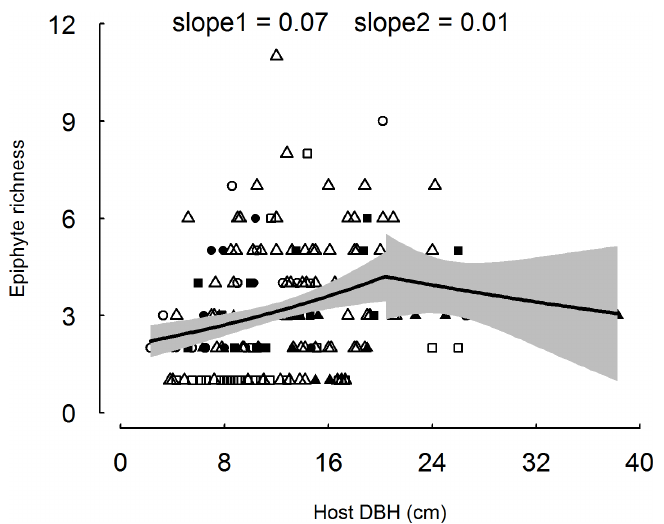
Fig 4. Relationship between the vascular epiphyte species richness and host tree diameter (DBH) across all six study species ( Engelhardtia roxburghiana , Ternstroemia gymnanthera , Syzygium buxifolium , Illicium ternstroemioides , Distylium racemosum and Cyclobalanopsis disciformis ), using a regression of breakpoints based on generalized linear model. Different symbols showed different host species. The lines represented locally weighted means and the shaded area represented 95% confidence